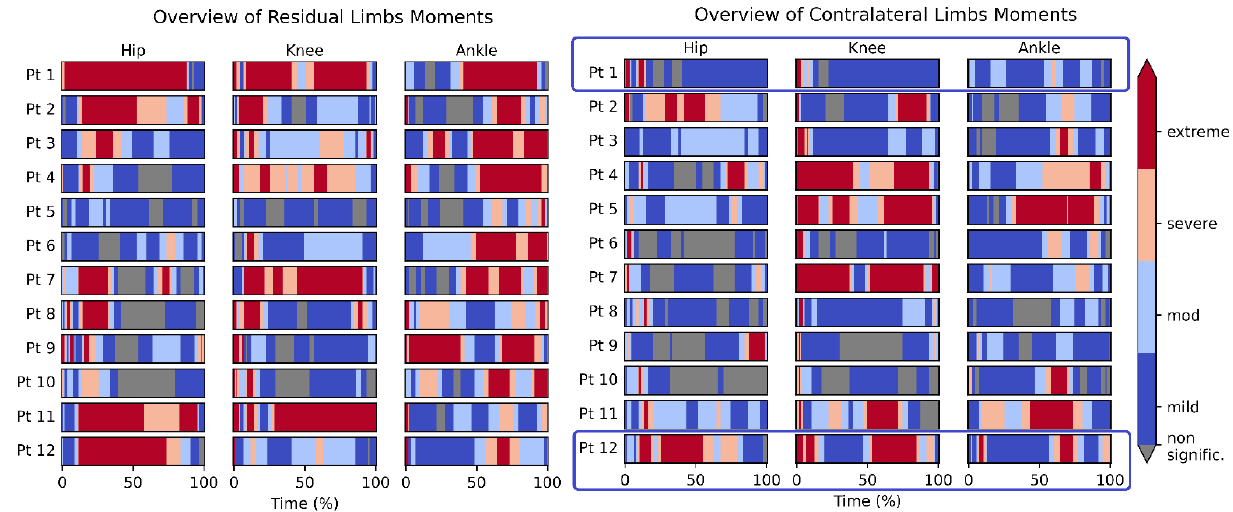
Figure 4. Overview of reference control moments. The color scheme used in this figure is identical in all figures.